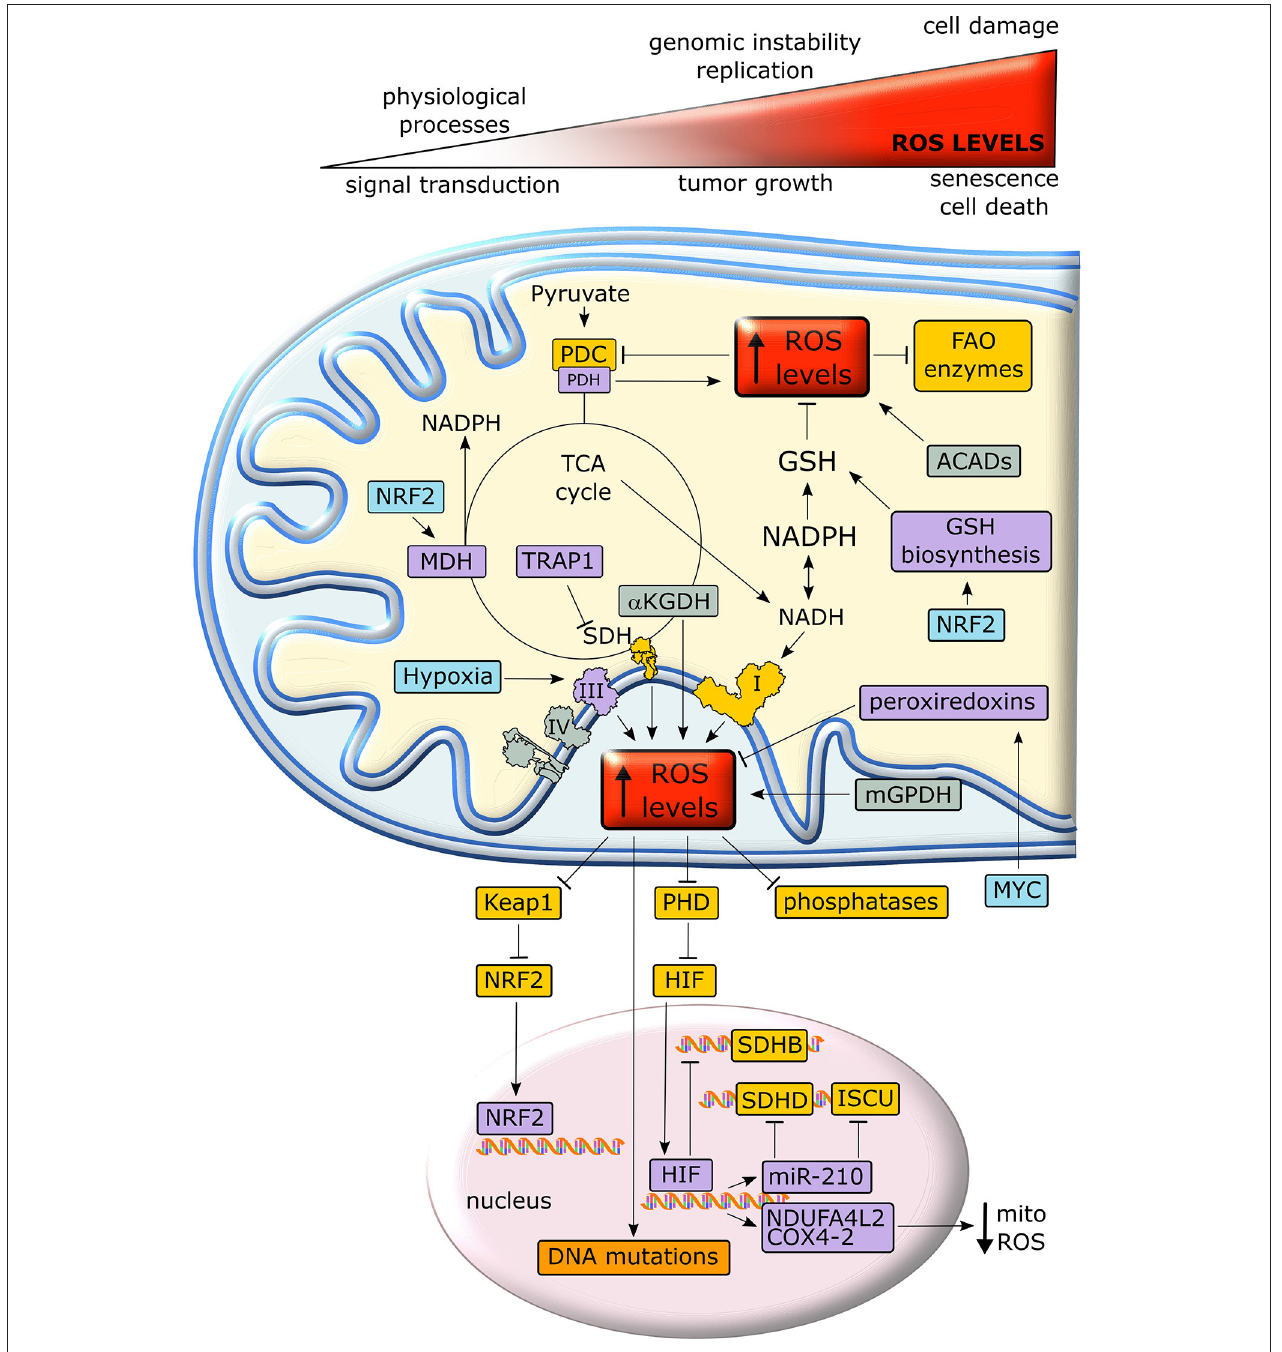
FIGURE 5 | Crosstalk between metabolism and redox homeostasis in cancer cell mitochondria. Neoplastic cells are characterized by high levels of mitochondrial ROS. Under a certain threshold, ROS facilitate tumor growth, but their excessive rise elicits oxidative damage and cell death. In cancer cell mitochondria, ROS levels are increased by respiratory chain complexes, α KGDH, mGPDH and ACADs and inhibit key enzymes of lipid metabolism and TCA cycle. In turn, ROS stimulate antioxidant defenses through stabilization of the transcription factors NRF2 and HIF1 α . Proteins overexpressed or activated in cancer cells are indicated in purple, whereas proteins whose activity is down-regulated are shown in yellow. GSH, reduced glutathione; PDC, pyruvate dehydrogenase complex; PDH, pyruvate dehydrogenase; α KGDH, alpha-ketoglutarate dehydrogenase; SDH, succinate dehydrogenase; SDHB, succinate dehydrogenase subunit B; SDHD, succinate dehydrogenase subunit D; MDH, malate dehydrogenase; TRAP1, TNF receptor-associated protein 1; FAO, fatty acid oxidation; ACAD, acyl-CoA dehydrogenase; mGPDH, mitochondrial glycerol-3-phosphate dehydrogenase; NRF2, nuclear factor-E2-related factor 2; PHD prolyl hydroxilase; Keap1, Kelch-like ECH-associated protein 1; NDUFA4L2, NADH dehydrogenase 1 alpha subcomplex, 4-like 2; COX4-2, Cytochrome c OXidase subunit 4 isoform 2; ISCU, Iron–Sulfur cluster assembly proteins.